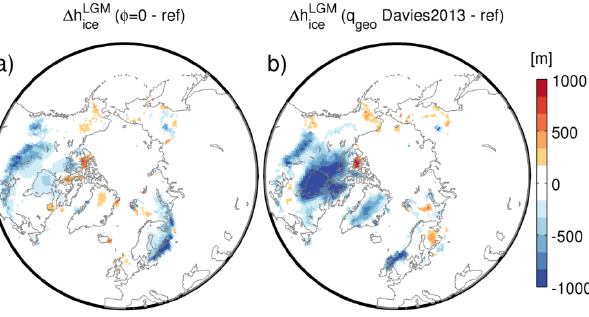
Figure 9. LGM (25–20ka) ice thickness difference between (a) the reference run and the simulation with zero porosity and (b) the one with the geothermal heat flux from Davies